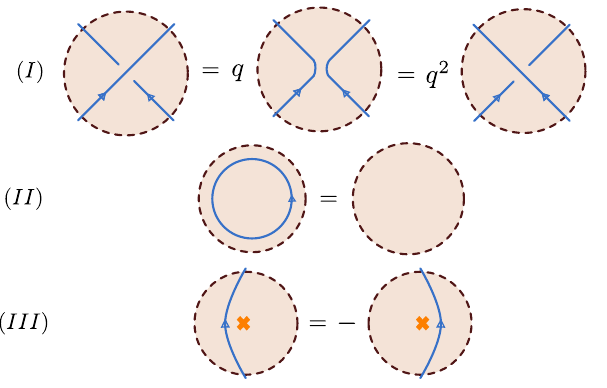
Figure 6 . The skein relations defining Sk( f M, gl (1)) for links in blackboard framing. The orange cross represents the codimension-2 branch locus F